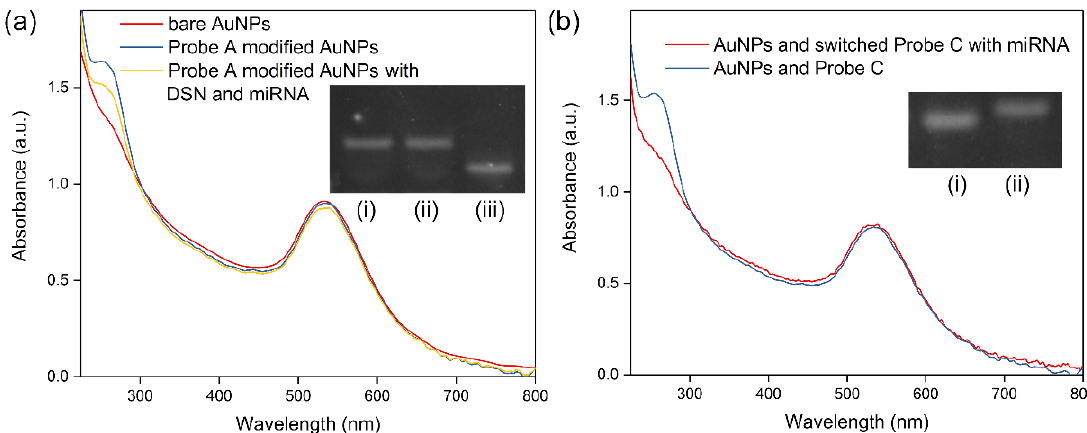
Figure 2. ( a ) UV − vis absorption spectra of bare AuNPs and Probe A modified AuNPs before and after treated with DSN in the presence of target miRNA. Inset is the PAGE image of (i) Probe A, (ii) Probe A after DSN treatment, and (iii) Probe A after DSN treatment in the presence of miRNA. ( b ) UV − vis absorption spectra of bare AuNPs treated with Probe C before and after the miRNA-mediated structural switch. Inset is the PAGE image of (i) Probe C, and (ii) the mixture of Probe B and C.